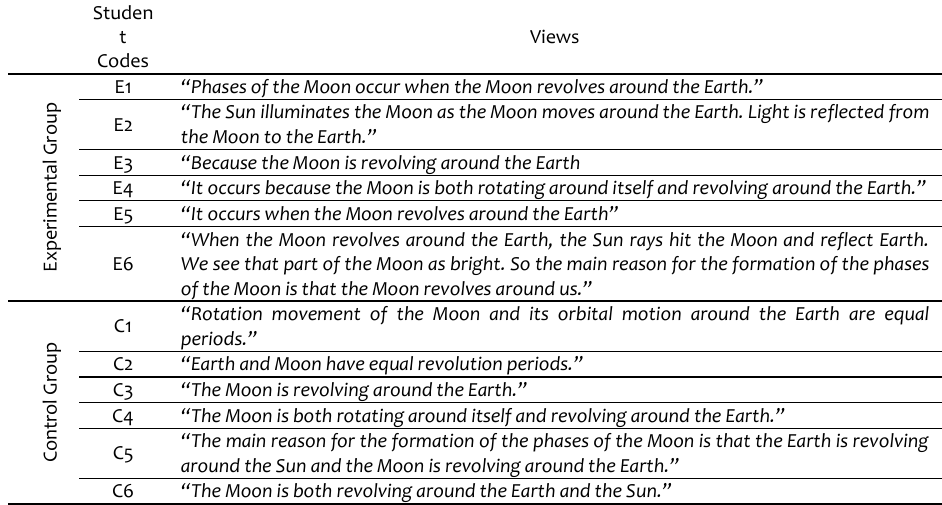
Table 8. The answers given by the interviewed students regarding the causes for the formation of the phases of the Moon Studen t